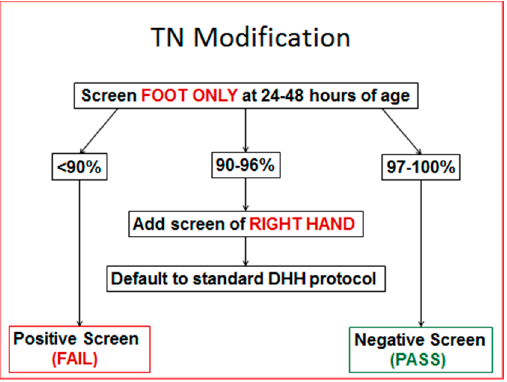
Figure 1. Foot only screen, if the pulse oximetry level is 97% or higher, the test is a pass and no upper extremity result is obtained, if the level is less than 90% the infant fails and is referred for further evaluation. A measurement of 90–96% results in a default to the AHA, CDC